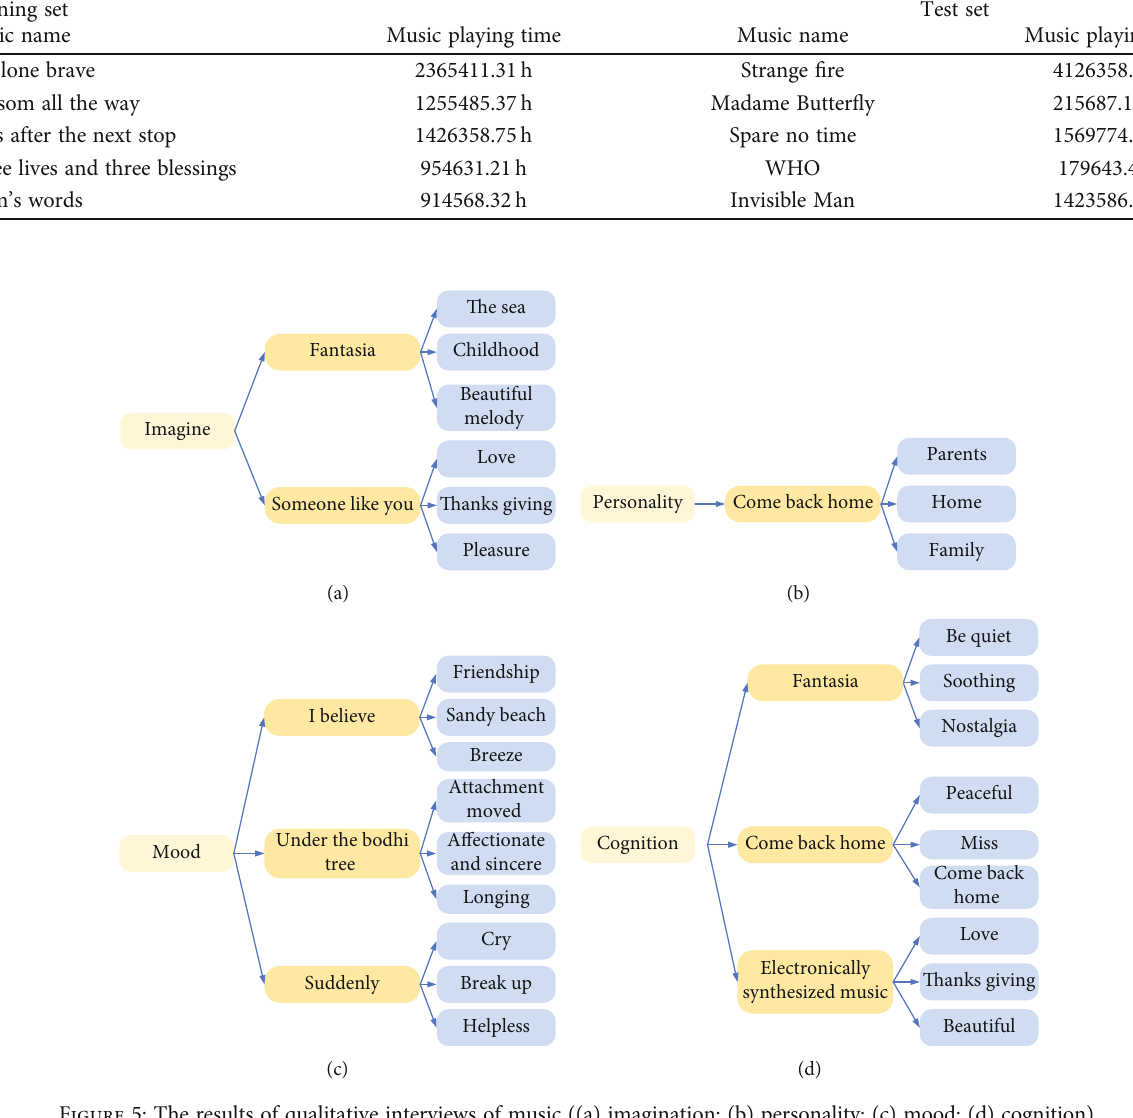
Figure 5: The results of qualitative interviews of music ((a) imagination; (b) personality; (c) mood; (d)